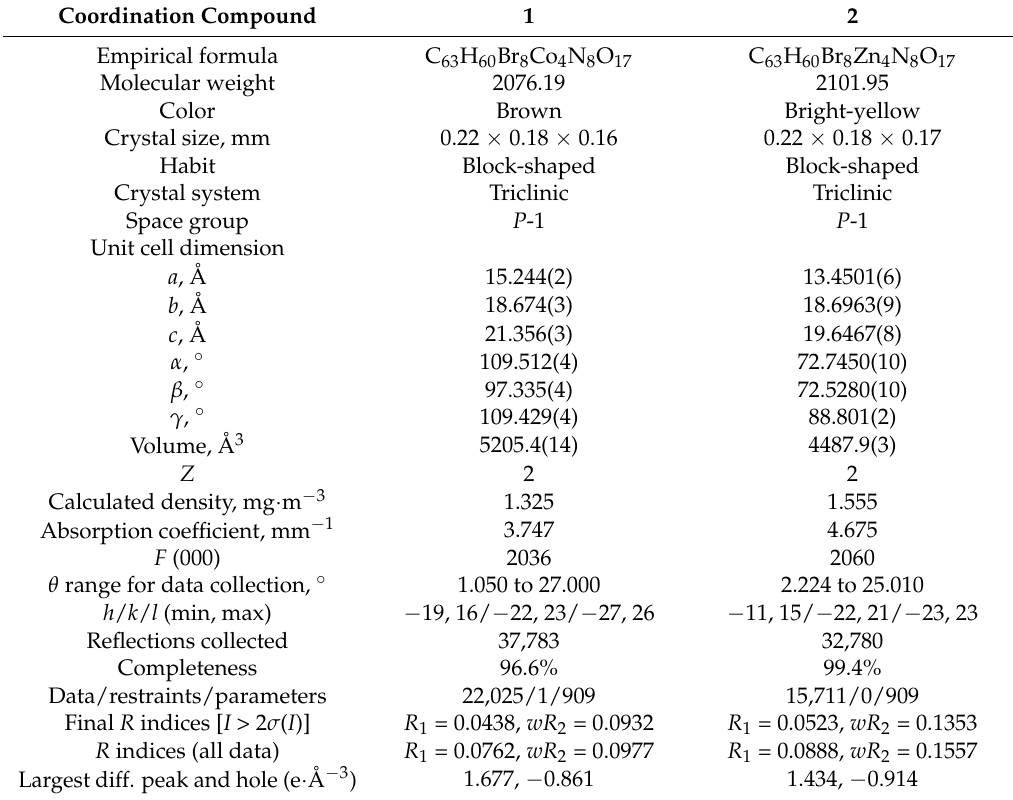
Table 4. Crystallographic data and refinement parameters for the coordination compounds 1 and 2